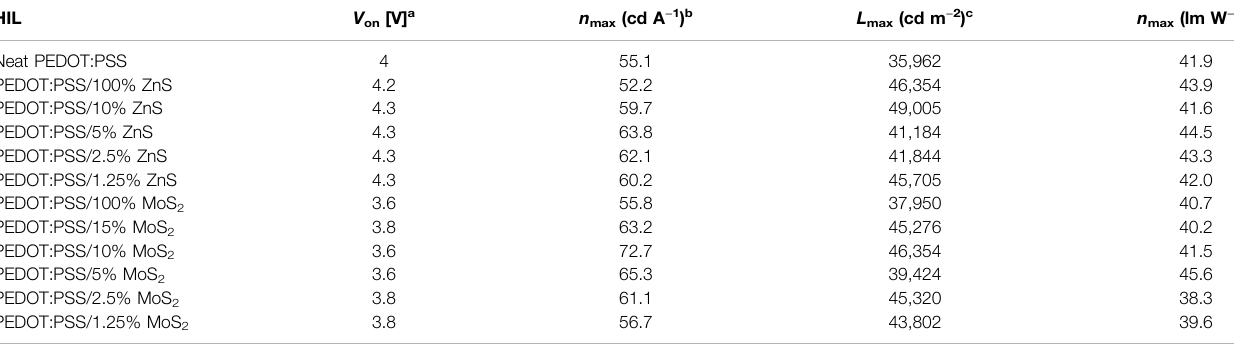
TABLE 1 | Performance parameters of the green phosphorescent OLED device with the various